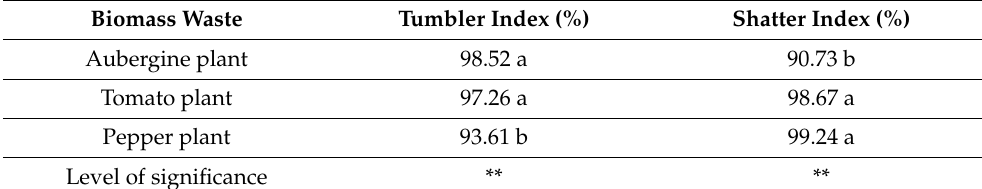
Table 4. Tumbler-Shatter resistance indexes and variance analysis results of obtained briquettes (on